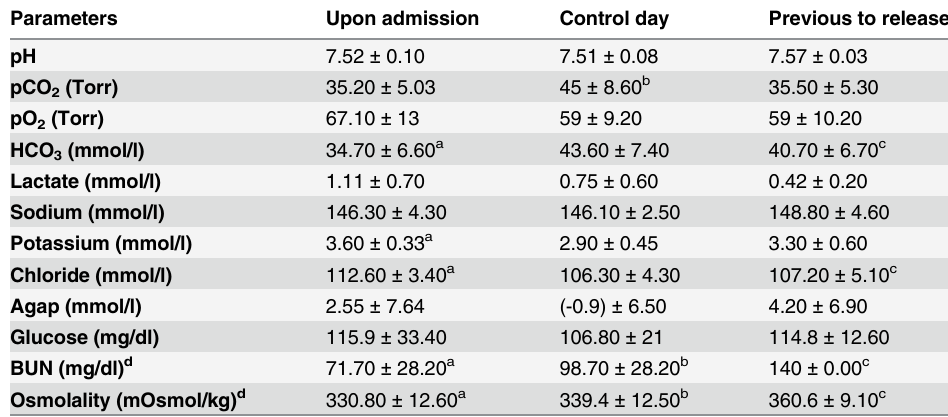
a Statistically signi fi cant differences between initial and control day values; b statistically signi fi cant differences between control day and convalescent values; c statistically signi fi cant differences between initial and convalescent values; d mean and standard deviation convalescent BUN and Osmolality underestimate the true values because BUN values exceeded the analytic range of the analyzer (140 mg/dl).